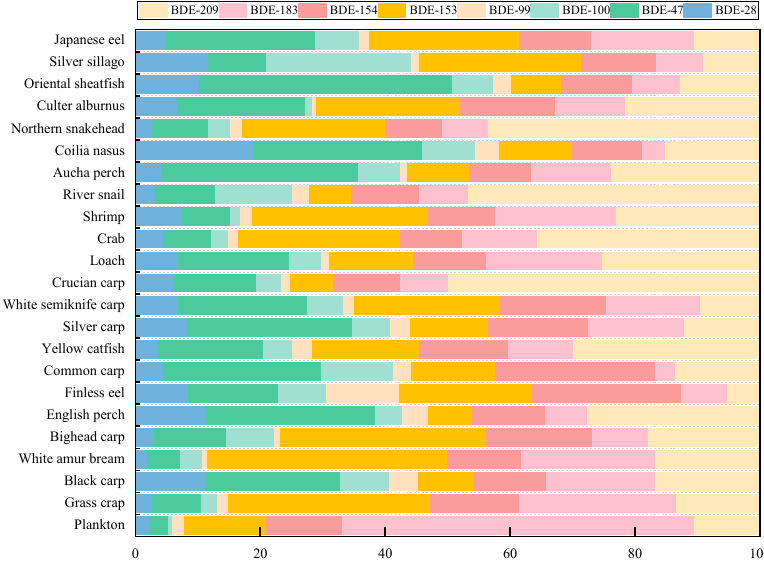
Figure 2. Composition profiles of PBDEs in aquatic organisms collected from typical shallow lakes.